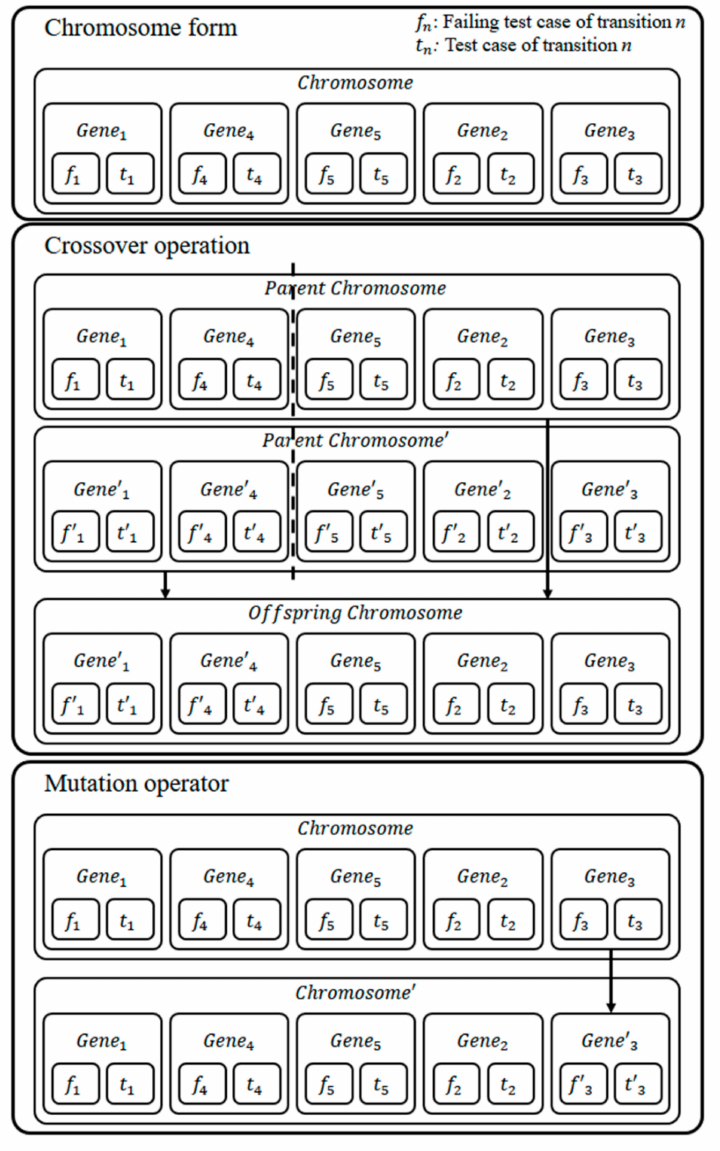
Figure 4. Chromosome form and gene operations used in this